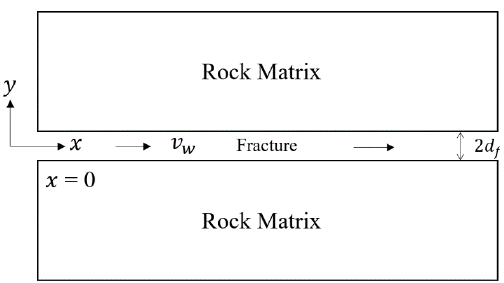
Figure 2. Geometry of the singe fracture TH model. Table 2. Parameters for single fracture